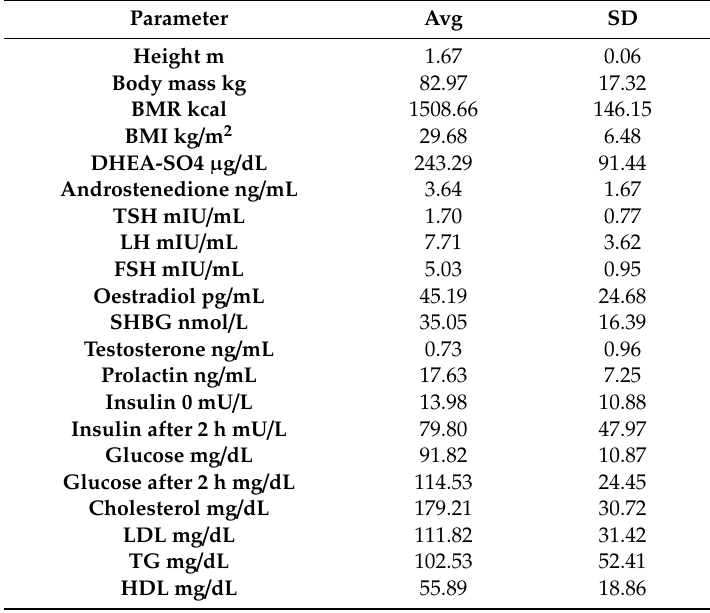
Table 4. Test details of women with PCOS before dietary